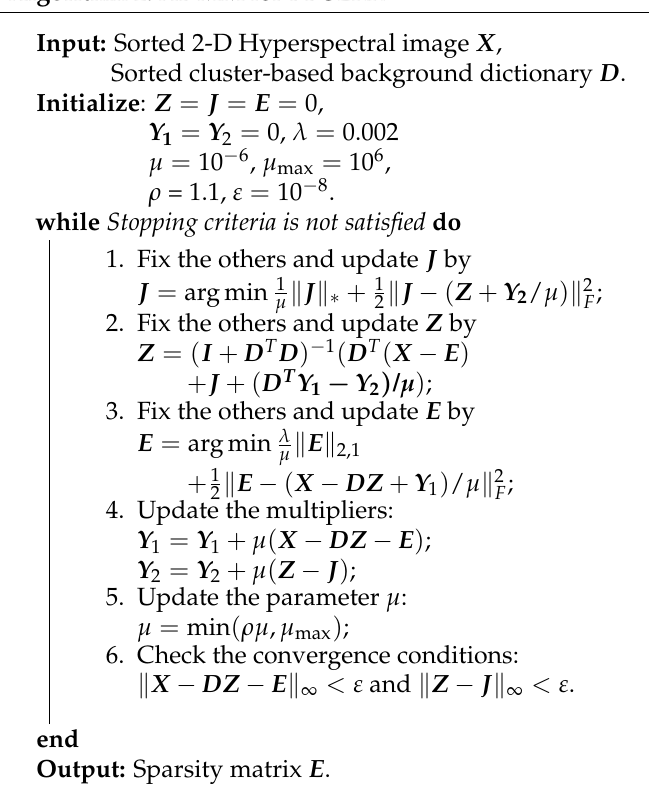
Algorithm 2: ADMM for